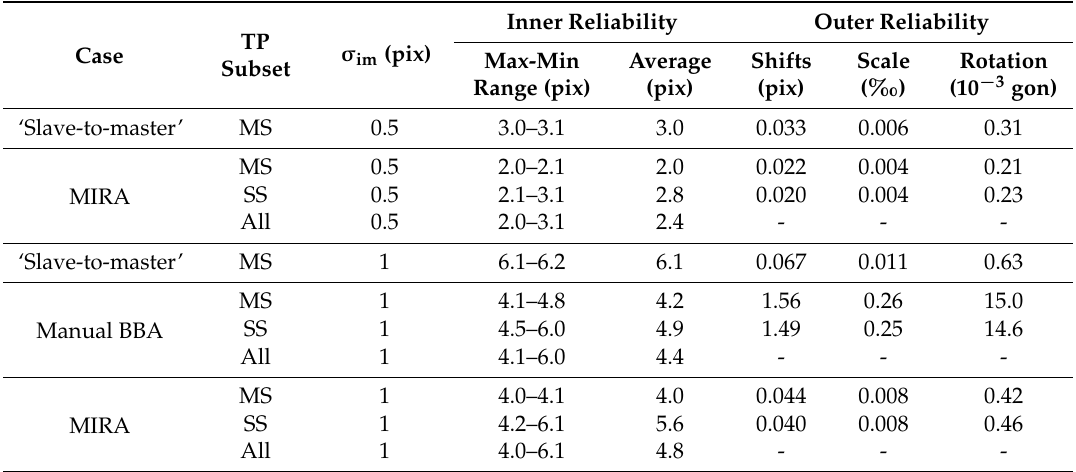
Table 8. Inner and outer reliabilities computed for the ‘Multan’ dataset. In the second column, the subset of TPs adopted for evaluating the inner/outer reliabilities are described using the following symbols: ‘MS’ is the subset of TPs shared between the ‘master’ and one or more ‘slaves’; ‘SS’ is the subset of TPs shared between two or more ‘slaves’; ‘All’ is the subset including all types of